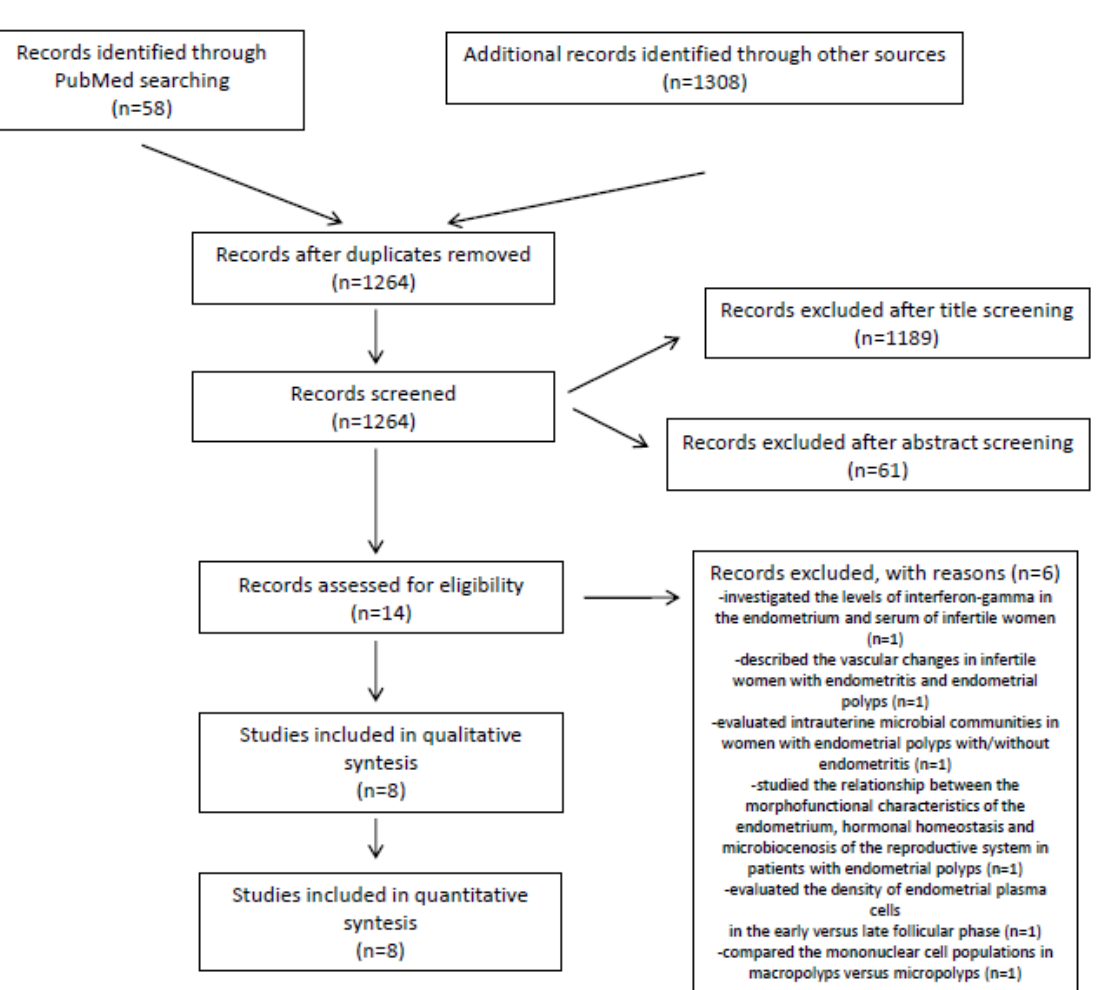
Figure 1. PRISMA Flow Diagram.